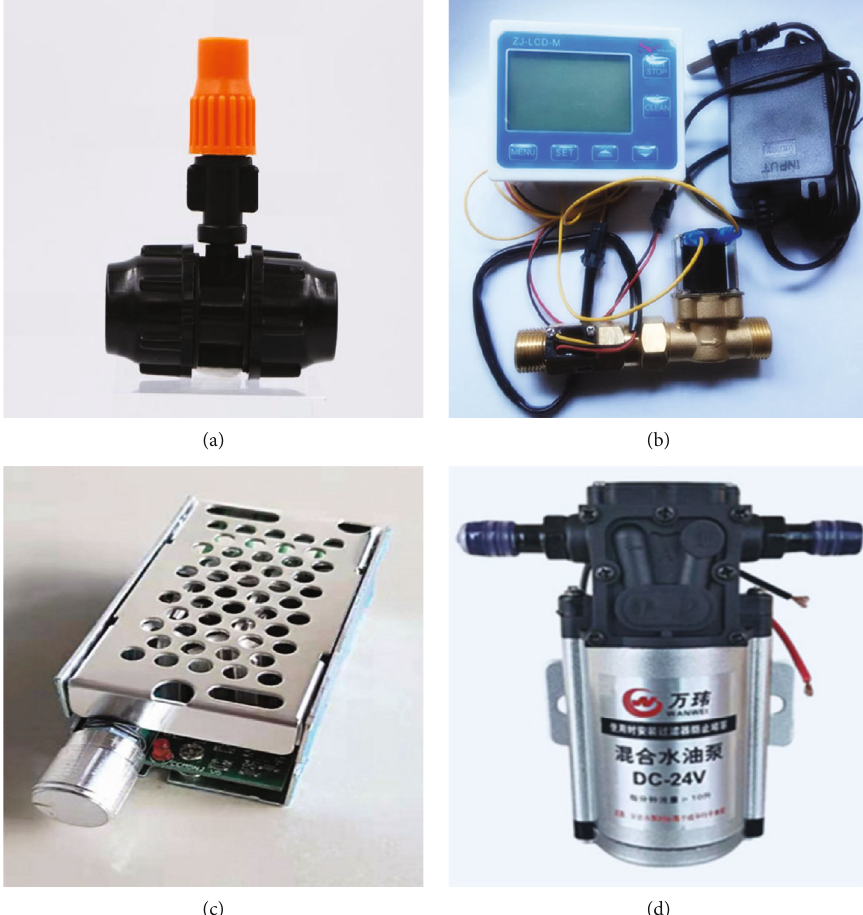
Figure 21: Rainfall and monitoring system.